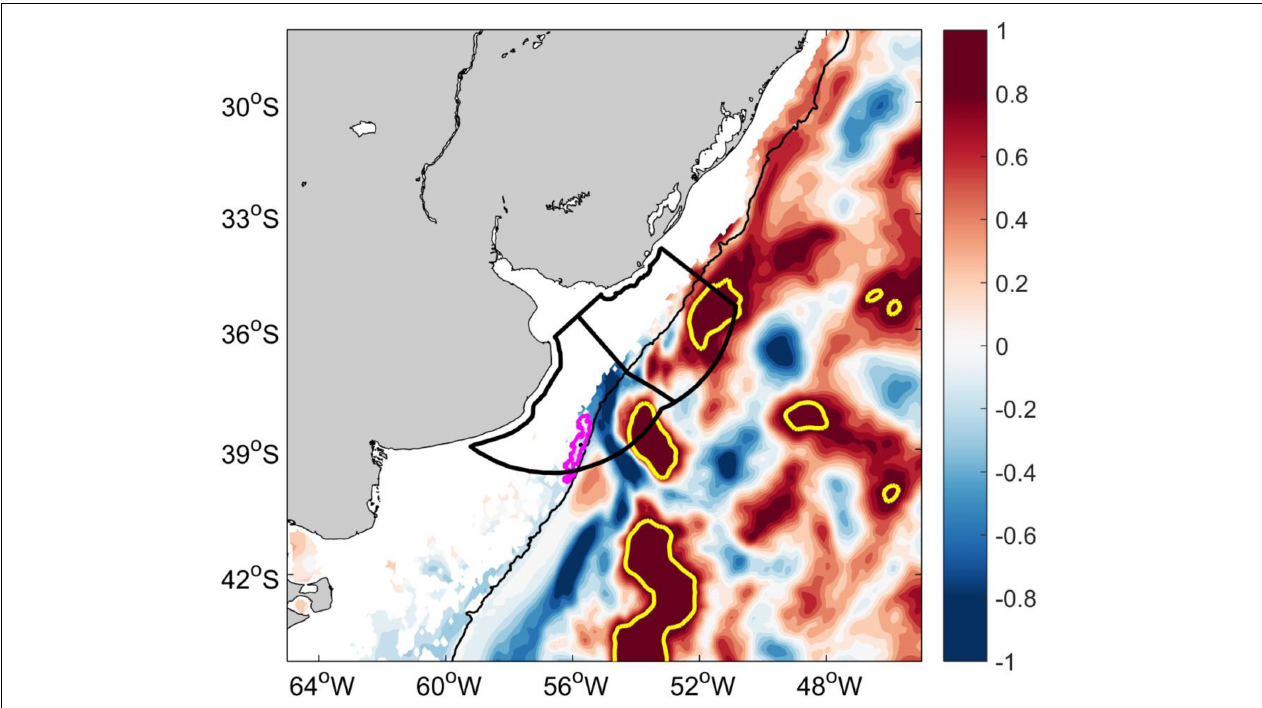
FIGURE 8 | GLORYS12 temperature trend ( ◦ C/decade) during spring of 2003–2017 at 92 m. The Argentina-Uruguay Common Fishing Zone (AUCFZ) is shown by two heavy-black polygons. The northernmost and largest Patagonian scallop bed is shown by a magenta polygon. Trends higher than 1 ◦ C/decade are depicted by a heavy yellow line. The 200 m isobath is shown in